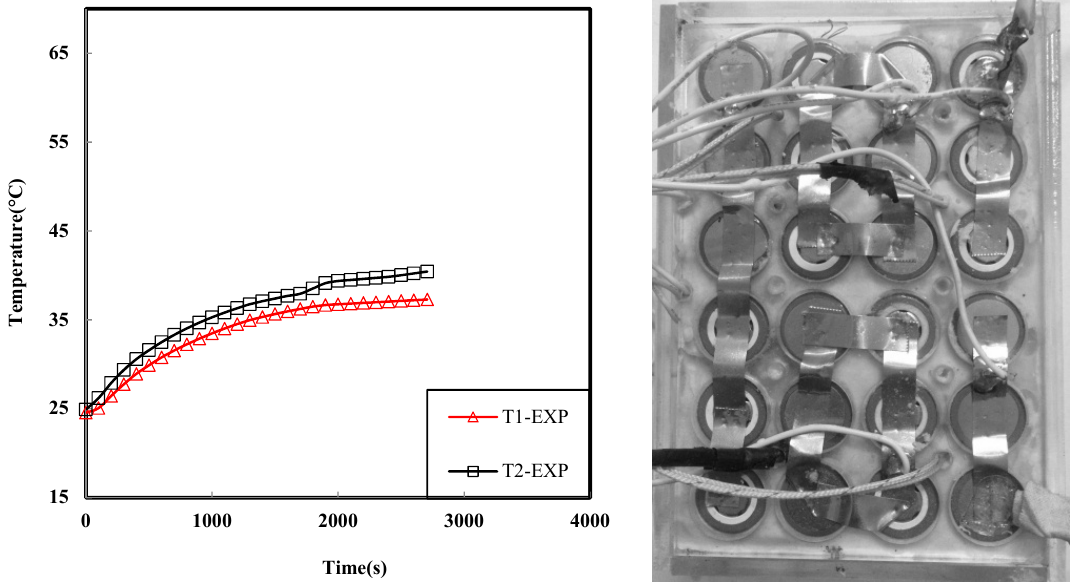
Figure 4. The temperature curve for the battery module and an image of the test setup using PCM under a 1.5C discharging rate.